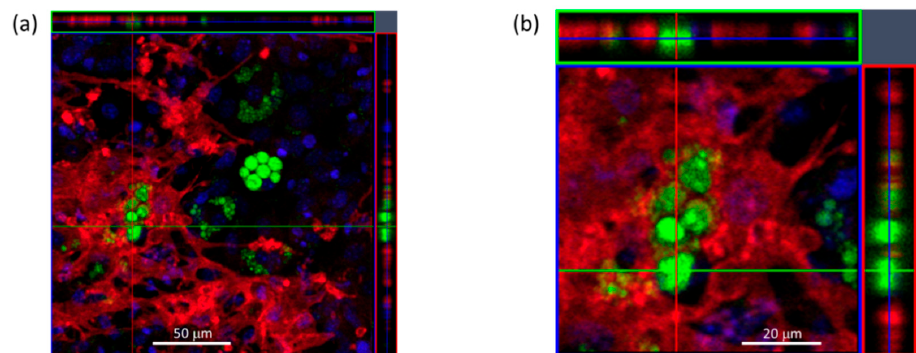
Figure 4. Confocal 3D imaging of differentiated MSC cultures after combined TC/BD/HT labelling at the endpoint. ( a ) Orthogonal views showing BD-positive adipocytes containing intracellular lipid droplets (green) surrounded by the TC-positive mineralised matrix (red), with HT (blue) nuclear counterstain, shown at higher magnification ( b ). Scale bar = 50 μ m ( a ) and 20 μ m ( b ). See additional 3D reconstruction in Supplementary Materials (Video S1 and S2).